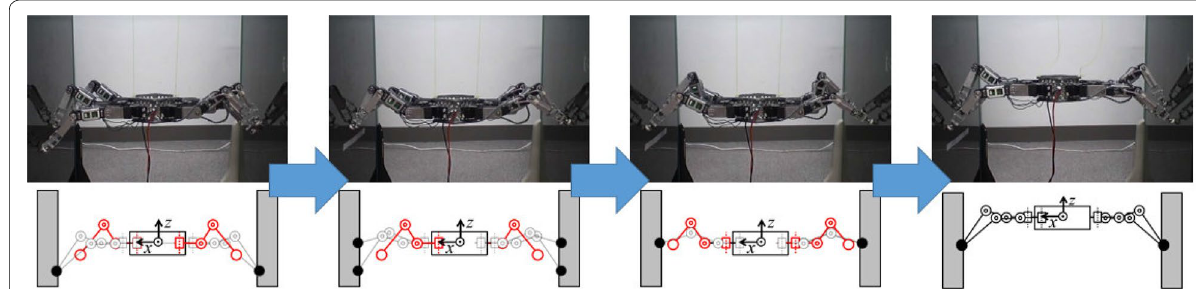
Fig. 7 Horizontal-body climbing gait